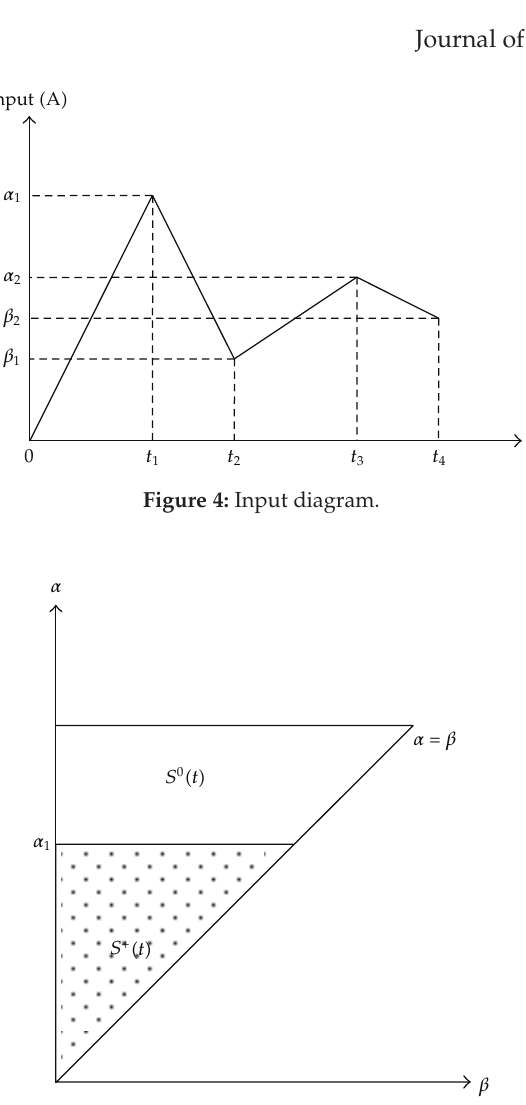
Figure 5: α - β plane due to input increasing to α 1